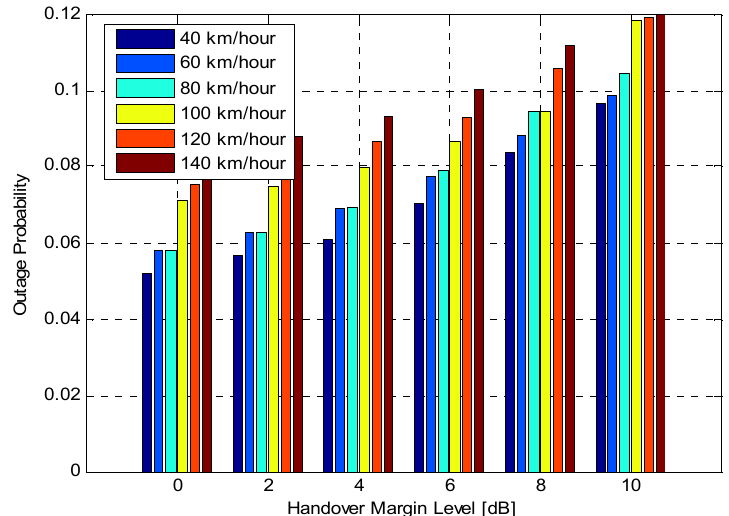
Figure 6. UE outage probability versus HOM level.